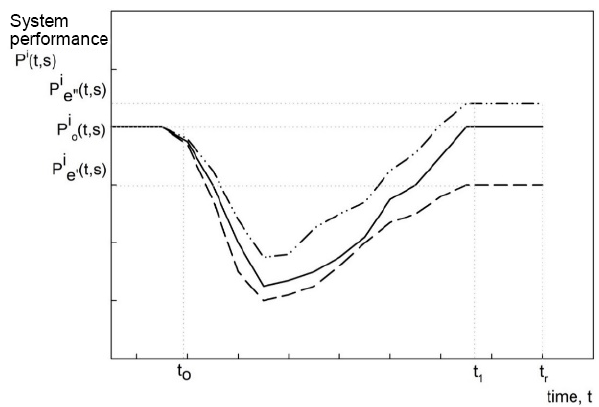
Figure 1. System